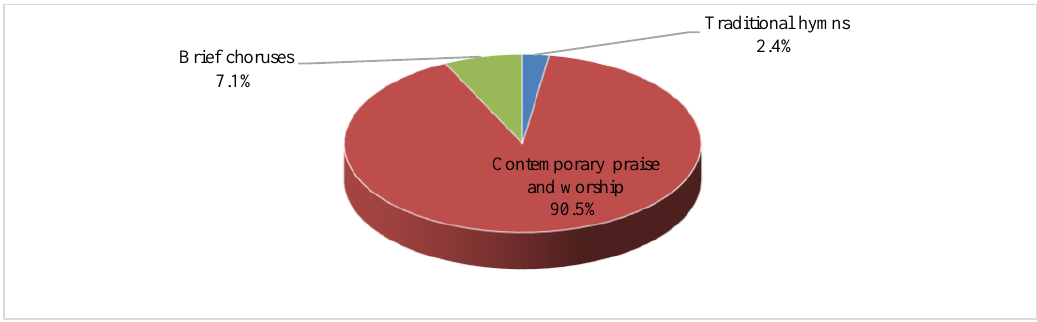
Figure 3: Style of Music Commonly Played at the Church; Source: Field Data